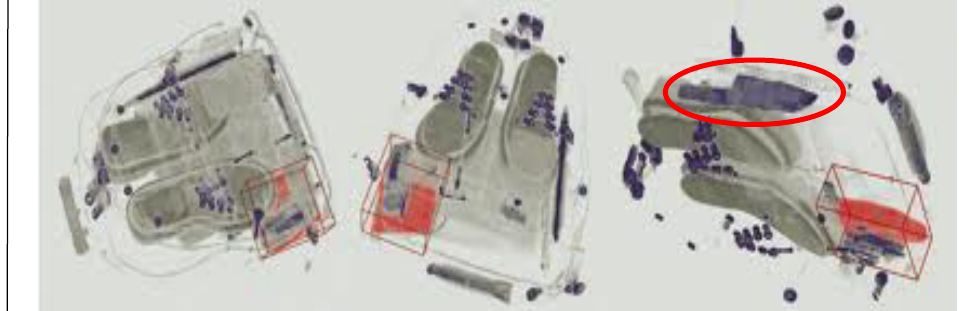
Figure 15 – 3D CT image and the possibility of its rotation in order to find objects that are not visible from the original angle (labeled: ceramic knife and